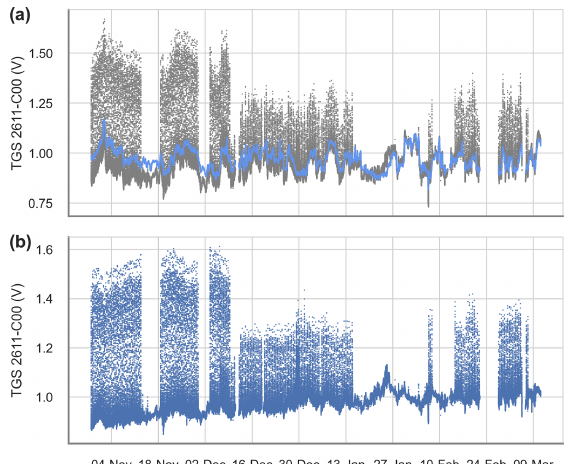
Figure A2. Derived contribution and correction of water vapor for the Figaro ® TGS 2611-C00. (a) The raw voltage signal (gray) and the derived cross-sensitivities to H 2 O (blue). (b) The cross-sensitivity-corrected signal.